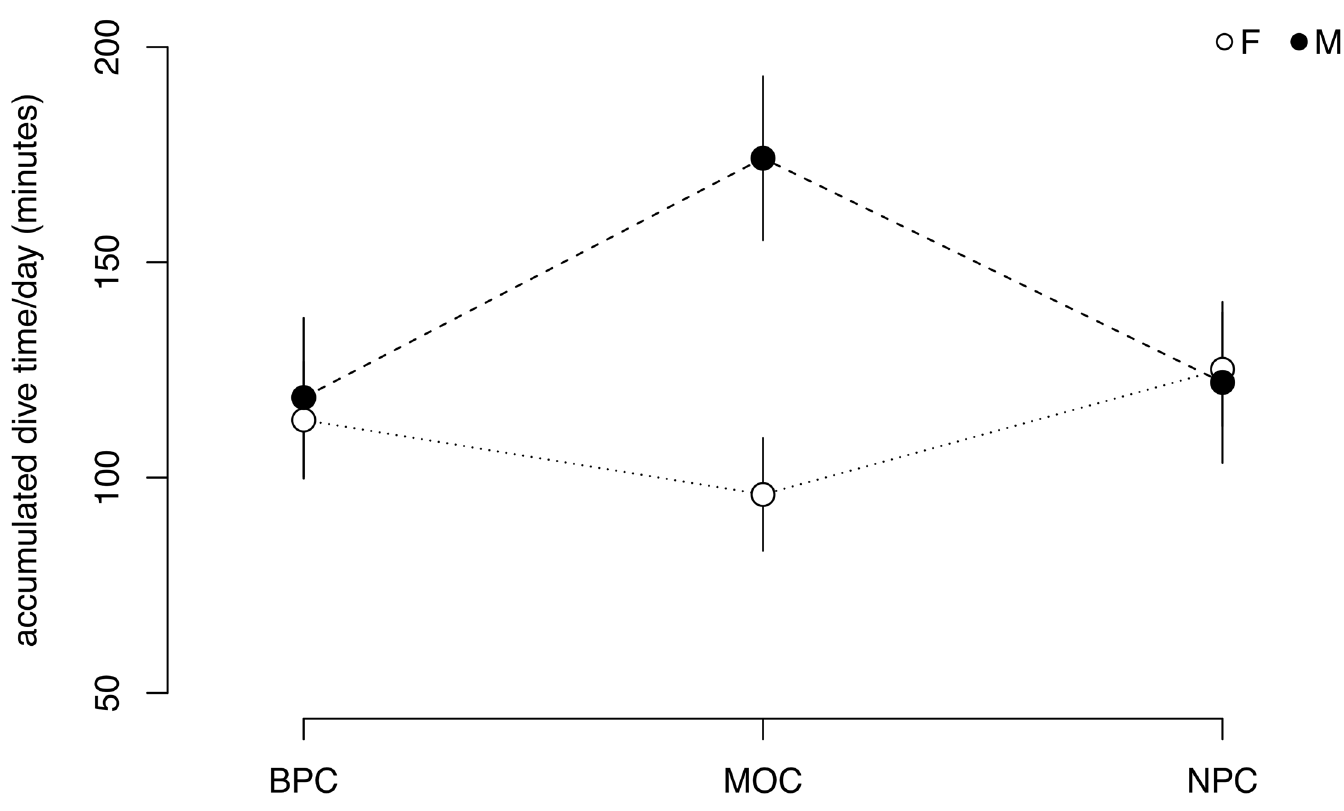
Fig 4. Mean accumulated daily dive time of female and male murres across successive stages of the annual cycle. Values are GLMM model fits ± confidence intervals. Sample sizes provided in S1 Table.